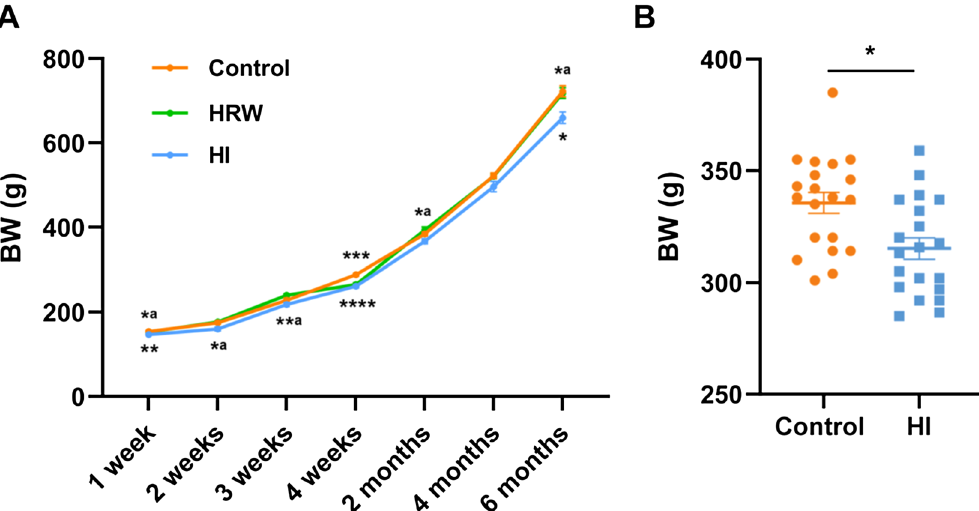
Figure 1. Effects of hydrogen treatment on body weight. ( A ) Body weight of rats in control, HRW and HI group was monitored throughout the six-month period. ( B ) The effect of HI on BW was further confirmed by another experiment in which rats in control and HI group treated with the same operation. Values shown are mean ± SEM (n = 10). For comparison of HRW or HI group and Control group, * p < 0.05, ** p < 0.01, *** p < 0.001, **** p < 0.0001. For comparsion of HRW and HI group, * a p < 0.05, ** a p < 0.01. Figure was made with GraphPad Prism 8.0.2, https ://www.graph pad.com/suppo rt/faq/prism -802-relea se-notes